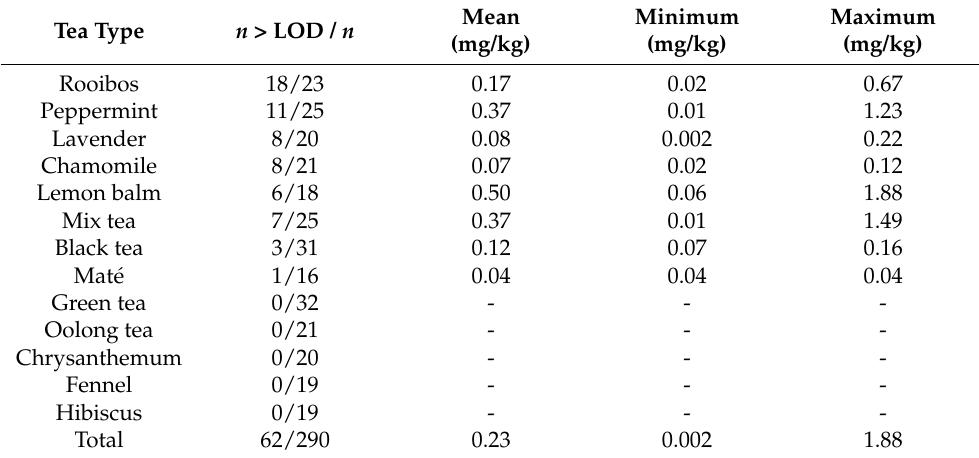
Table 4. Total PA concentration in